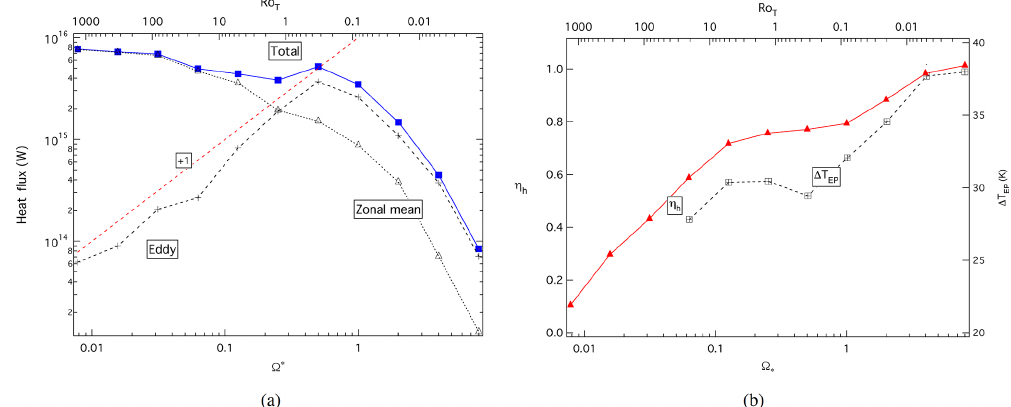
Figure 11. (a) Variations of peak values of meridional heat transport (W) within the PUMA GCM simulations of Wang et al. (2018) and at slower values of (cid:127) , shown as total poleward transport (blue squares), zonal-mean transport ( (cid:82) [ c p vT ] 2 πa cos (φ max ) d p/g ) and eddy transport ( (cid:82) [ c p v ∗ T ∗ ] 2 πa cos (φ max ) d p/g ); (b) ratio η of the slope obtained in fully active circulations in the latitude–height plane for experiments with different (cid:127) ∗ values to the globally mass-weighted average isentropic slope in radiative–convective equilibrium (towards which the model atmosphere relaxes; shown as filled triangles connected by solid lines), plotted alongside the variation of mean equator–pole thermal contrast in the mid-troposphere, (cid:49)T EP (shown as open squares connected by a dotted line). The (red) dashed line in (a) indicates a gradient of + 1 with respect to (cid:127) , suggesting linear